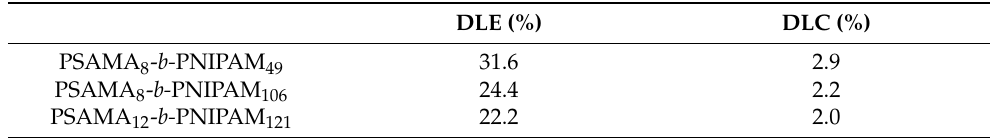
Table 2. Drug loading characteristics of CBZ-loaded micelles.